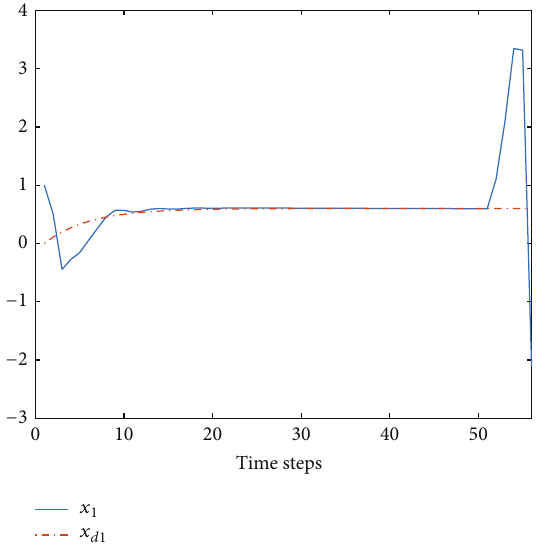
Figure 4: The state trajectory 𝑥 1 and desired trajectory 𝑥 𝑑1 .